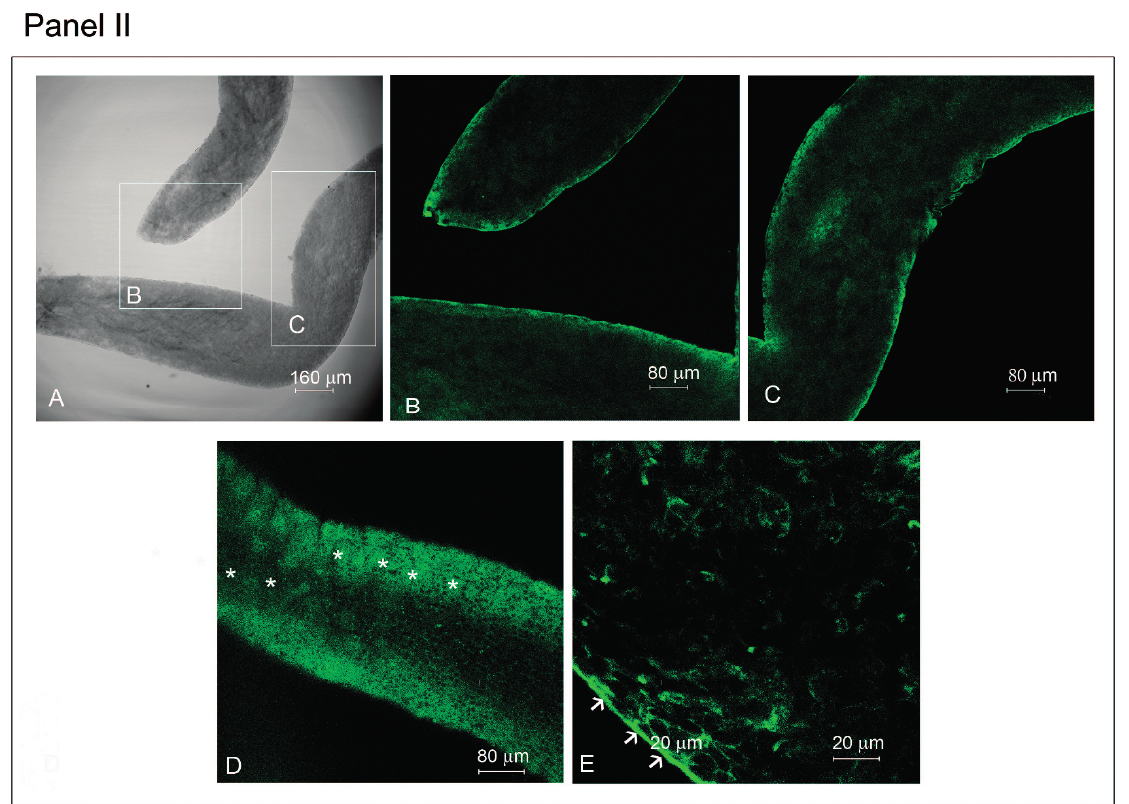
Figure 5. Confocal analysis of Met immunolocalization in prepubertal and adult rat seminiferous tubules. ( Panel I ): ( A ) Met distribution pattern in the peritubular compartment is shown. ( a ) Higher magnification of the square drawn in ( A ); asterisks indicate myoid cells. ( B ) Met distribution pattern imaged at the internal level of the same seminiferous tubule of ( A ). ( b ) Higher magnification of the square drawn in ( B ); arrows indicate myoid cells; ( Panel II ): ( A ) Transmission bright field images of seminiferous tubules at Stages VI–VIII ( B ) and I–V ( C ). ( B , C ) Relative Met distribution pattern at the internal level of the tubules shown in the squares in ( A ). ( D ) Met distribution pattern imaged at the peritubular myoid level of a seminiferous tubule at Stages VI–VIII. Asterisks indicate myoid cells. ( E ) Met distribution pattern imaged at the internal level of a seminiferous tubule at Stage X. Arrows indicate myoid